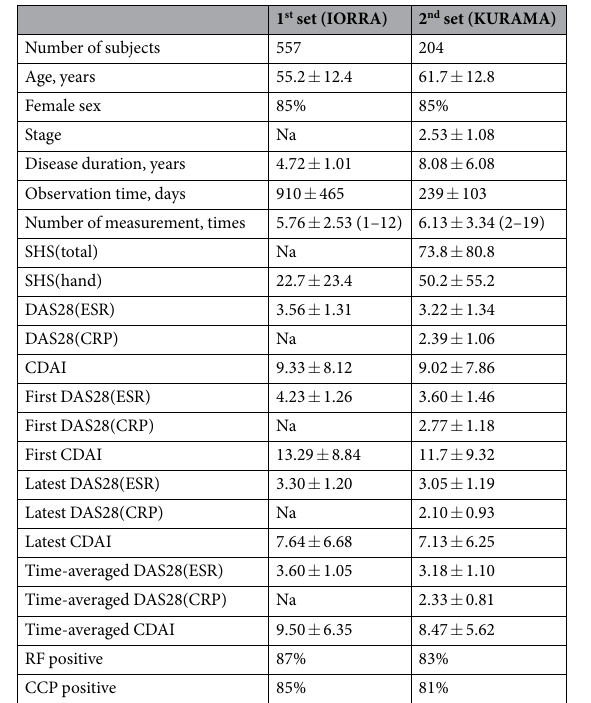
Table 1. Baseline characteristics of patients for the assessment of time-averaged DAS28 in the Japanese